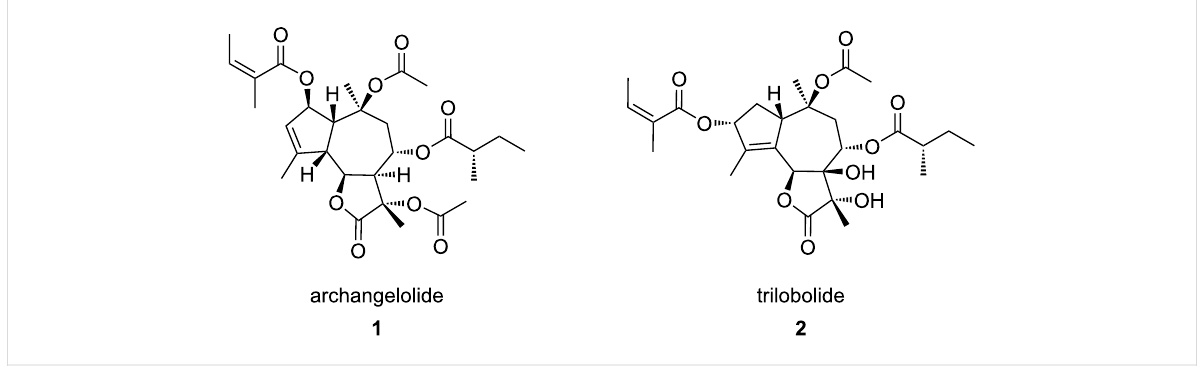
Figure 1: The structure of the sesquiterpene lactones archangelolide ( 1 ) and trilobolide ( 2